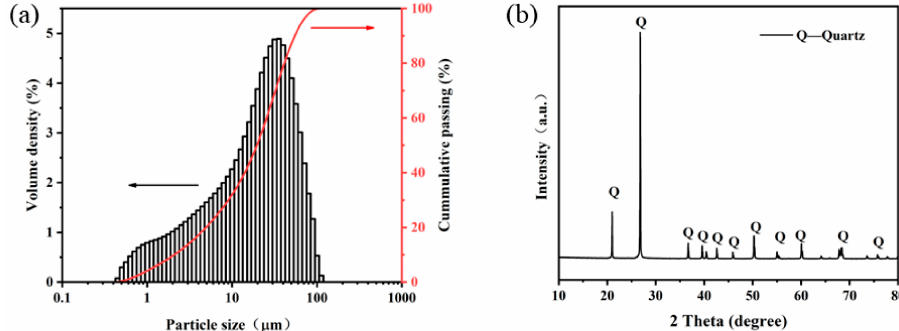
Figure 1. ( a ) Particle Size Distribution (PSD); ( b ) XRD pattern of quartz sample.